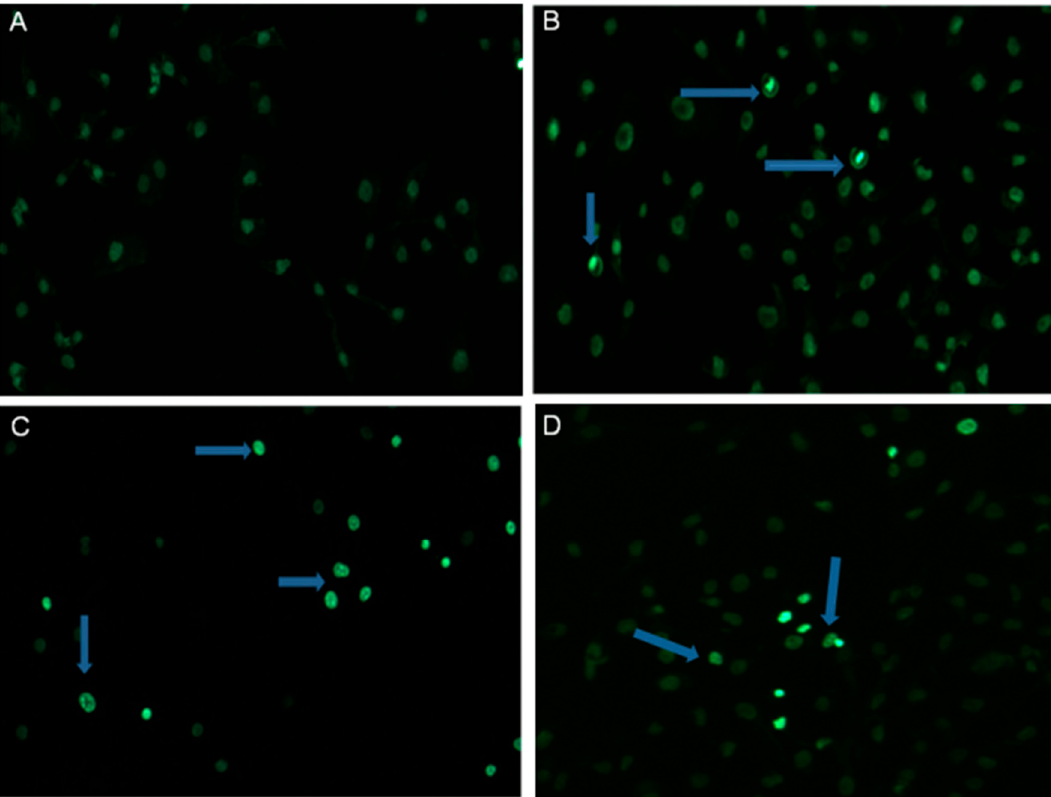
Figure 4. Apoptotic changes induced in SKOV-3 cells by α -HN. The state of SKOV-3 nuclear chromatin after treating with 0.1% DMSO ( A ) or α -HN at concentration of 0.5, 2 and 10 µ g / mL ( B – D ) was evaluated by Hoechst 33342 staining. The cells after treatment with α -HN depict condensed chromatin (contrary to the DMSO control cells). Arrows point out apoptotic cells.